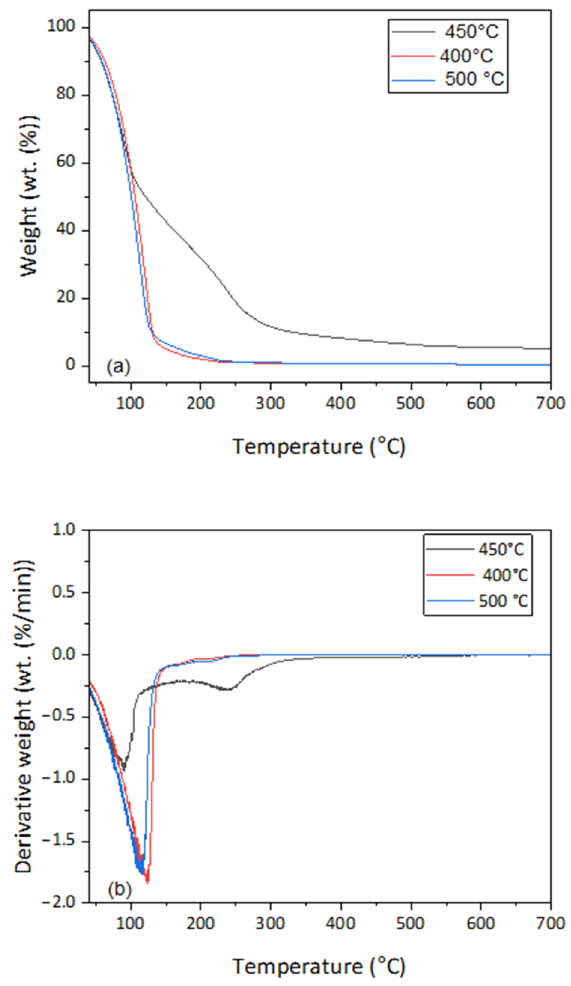
Figure 5. Thermal behavior of bio-oil produced from teff husk pyrolysis: ( a ) thermogravimetric curves (TG) and ( b ) derivative thermogravimetric (DTG).